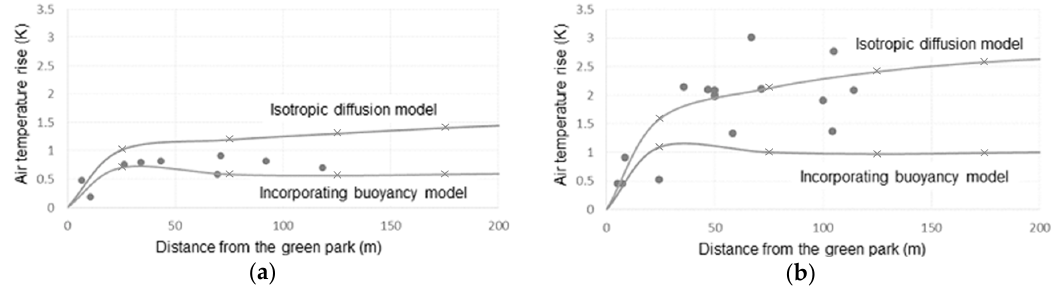
Figure 5. Calculation results and measurement results of air temperature rise at 13:00 according to the distance from the green area. ( a ) strong wind case; ( b ) weak wind case.